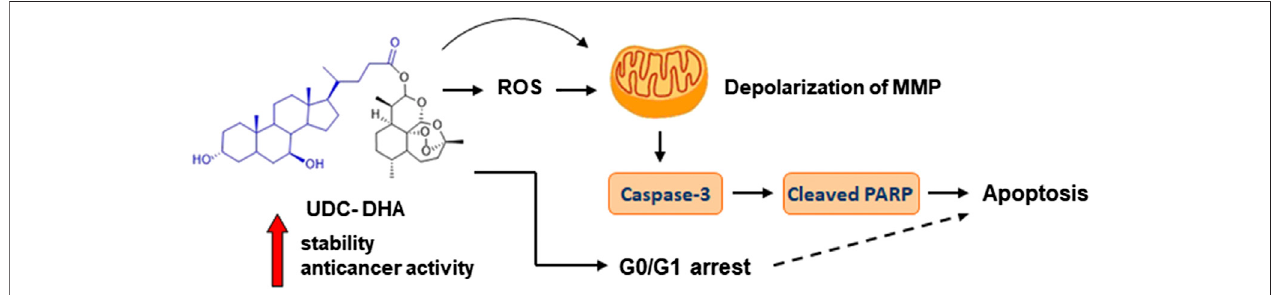
FIGURE 8 | UDC-DHA induces G0/G1 arrest and apoptosis in HCC cells with markedly increased stability and anticancer activity compared to DHA.